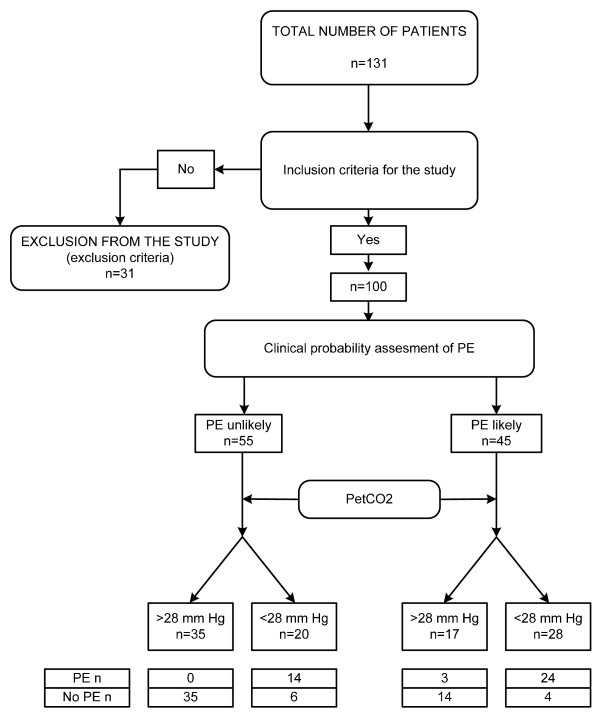
The flow diagram of recruitment, exclusion and subsequent grouping of all patients in the study. PE = pulmonary embolism; PetCO2 = partial pressure of end-tidal carbon dioxide.